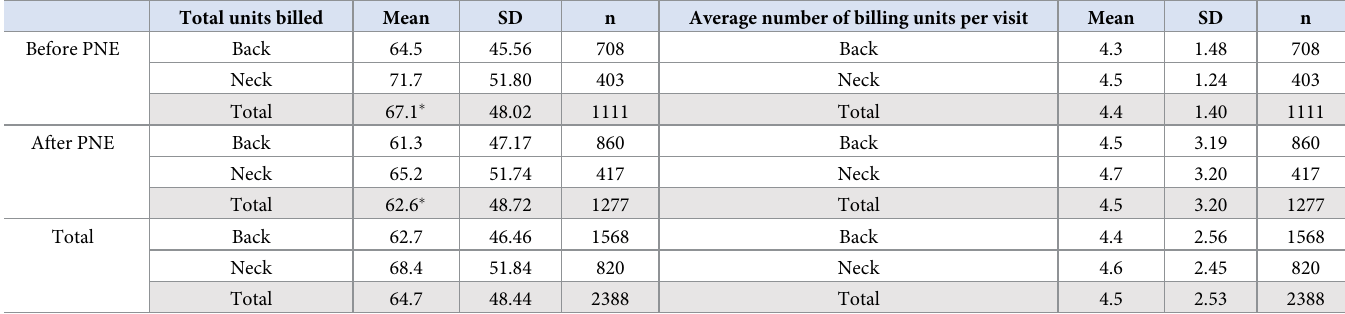
� Indicates statistically significant